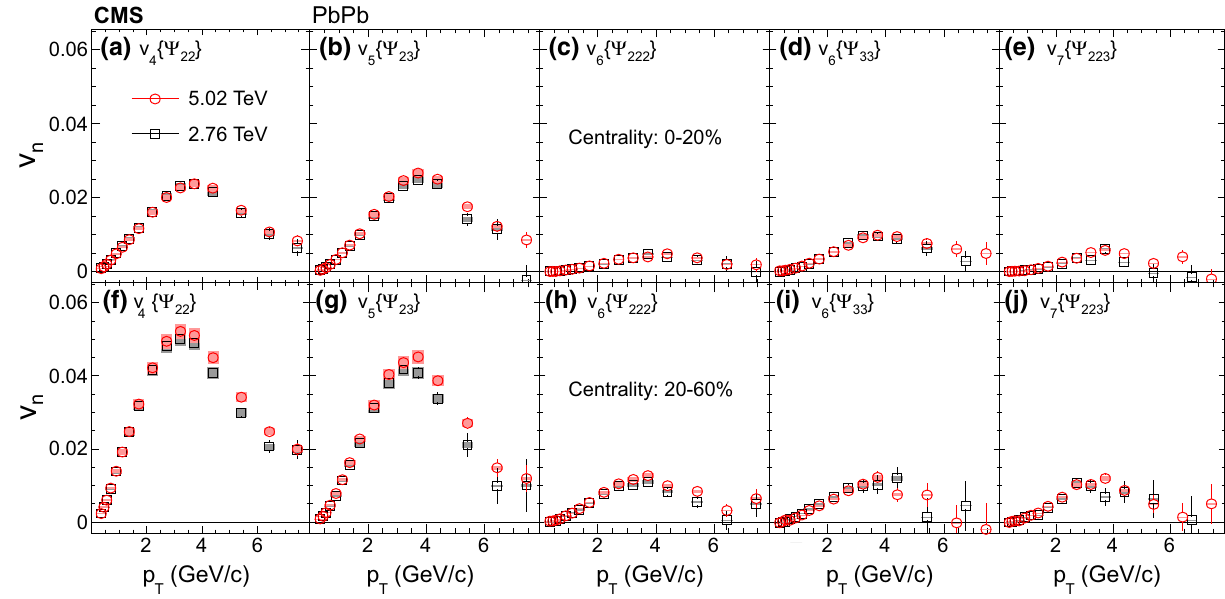
Fig. 1 Mixed higher-order flow harmonics, v 4 { Ψ 22 } , v 5 { Ψ 23 } , v { Ψ } , v { Ψ } , and v { Ψ } from the scalar-product method at √ 6 222 6 33 7 223 = 2 . 76 and 5.02TeV as a function of p s NN